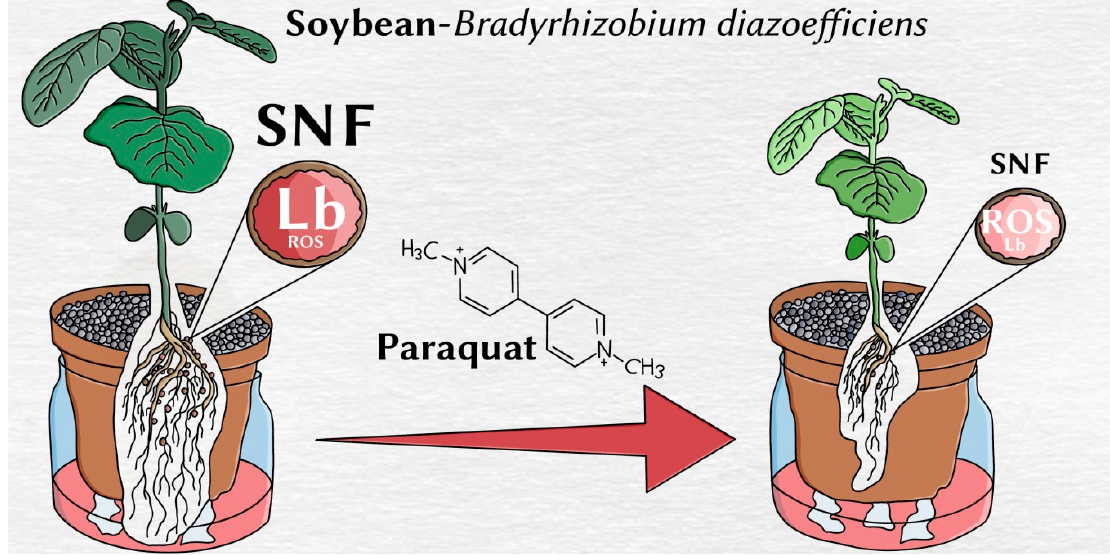
Figure 4. An overview of the main effect of paraquat in the soybean– B. diazoefficiens symbiosis. SNF: symbiotic nitrogen fixation; Lb: leghaemoglobin; ROS: reactive oxygen species.